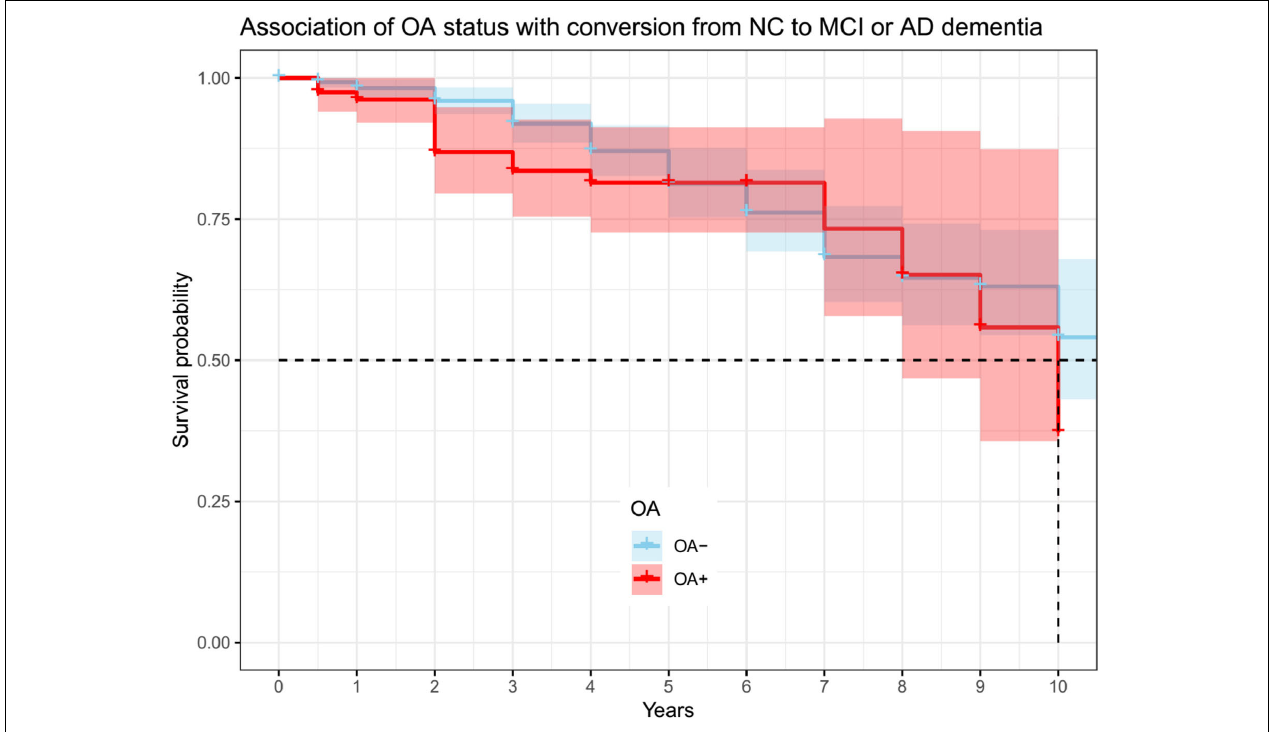
FIGURE 3 | Association of OA status with conversion from NC to MCI or AD dementia. OA status was not associated with conversion from NC to MCI or AD dementia (OA + : HR = 1.6, se = 0.28, p = 0.09). OA: osteoarthritis; NC: normal cognition; MCI: mild cognitive impairment; AD: Alzheimer’s disease. TABLE 2 | Summary of linear mixed models examining the association of OA status with changes in global cognition over time among older individuals with NC. Predictors